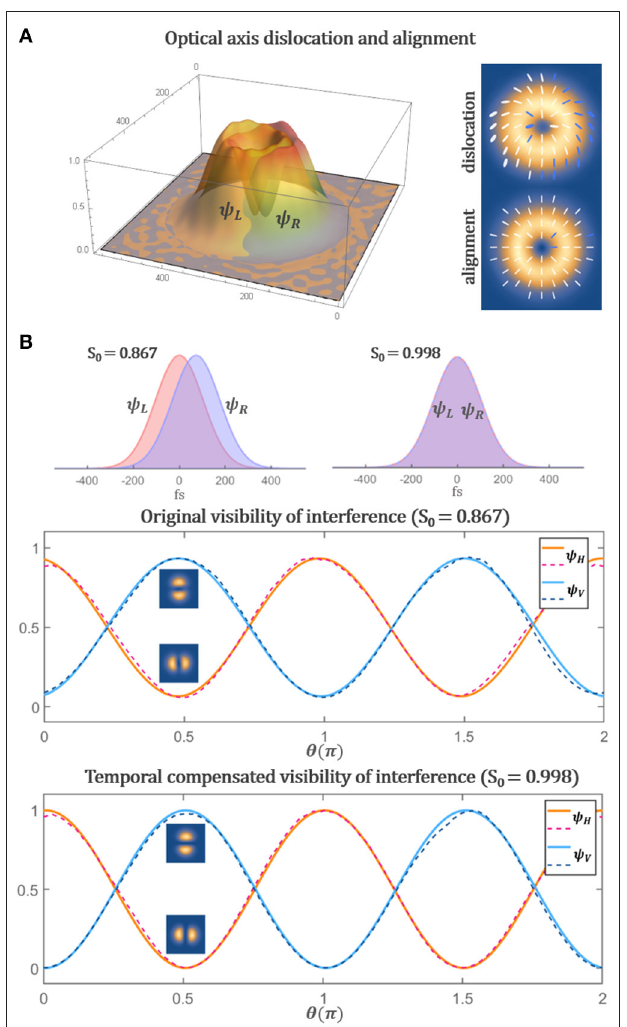
FIGURE 3 | Results of the compensation of the transverse (A) and temporal (B) dislocations.